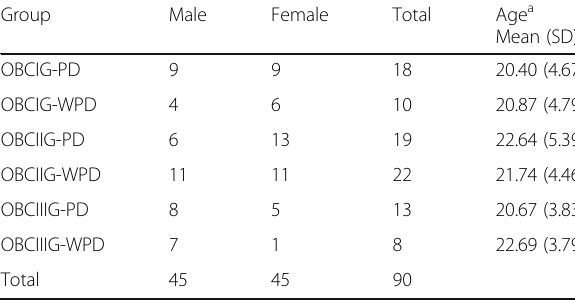
Table 1 Sample distribution by group, sex, and